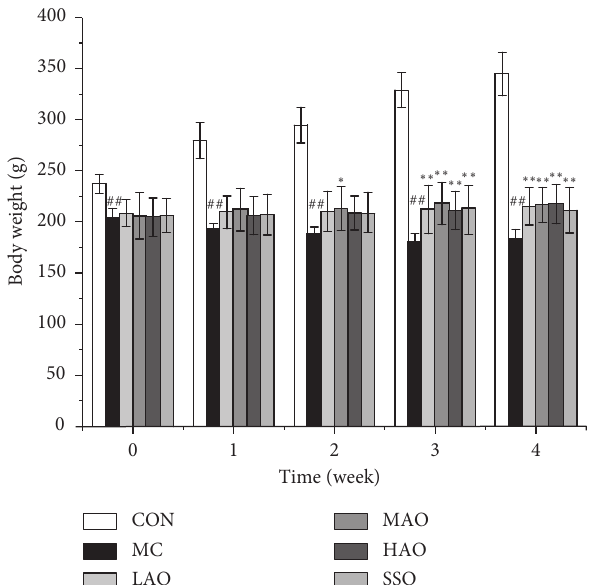
Figure 1: Effect of almond oil on body weight in STZ-induced diabetic rats. CON, control group; MC, model control group; LAO, low dose of almond oil-treated group; MAO, middle dose of almond oil-treated group; HAO, high dose of almond oil-treated group; SSO, sunflower seed oil-treated group. Data were expressed as means ± SD. The MC group compared with the CON group, # P < 0 . 05, ## P < 0 . 01; the LAO, MAO, HAO, and SSO groups compared with the MC group, ∗ P < 0 . 05, ∗∗ P < 0 .